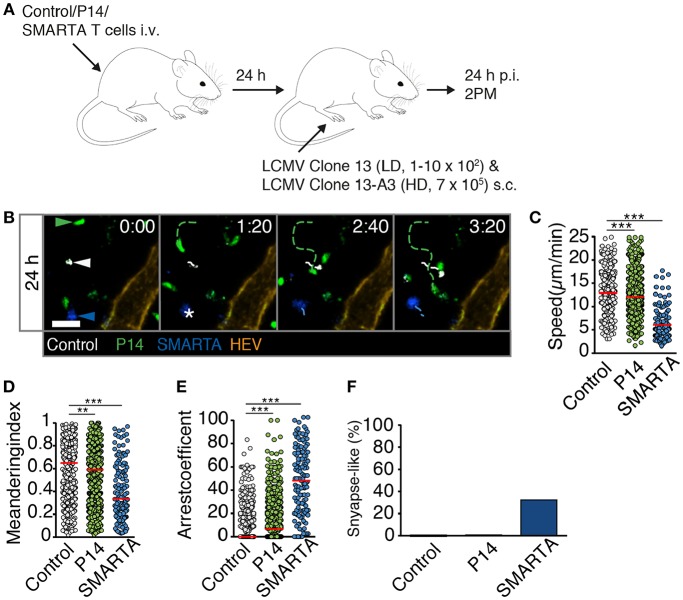
High viral inoculum induces immediate T cell arrest through high pMHC levels in reactive LNs. (A) Experimental layout. Fluorescently labeled control, P14, and SMARTA T cells were analyzed by 2PM microscopy at 24 h post co-infection with HD LCMV Clone 13-A3 and LD Clone 13. (B) Representative 2PM images of control (white), P14 (green), and SMARTA T cell tracks (blue) with HEV (orange). Arrowheads point the tracked cell and * indicates complete T cell arrest. Scale bar, 20 μm. (C–F) Quantification of 2PM motility parameters: Migration speed (C), Meandering index (D), arrest coefficient (E), and percentage of synapse-like T cell motility (F) of control (gray), P14 (green), and SMARTA T cells (blue). Red bars depict median. Each dot represents a single track. Data are pooled from four independent experiments with a total of eight mice. Statistical significance was analyzed by unpaired Mann-Whitney test of control vs. P14 and SMARTA T cells, respectively. **p < 0.01; ***p < 0.001.